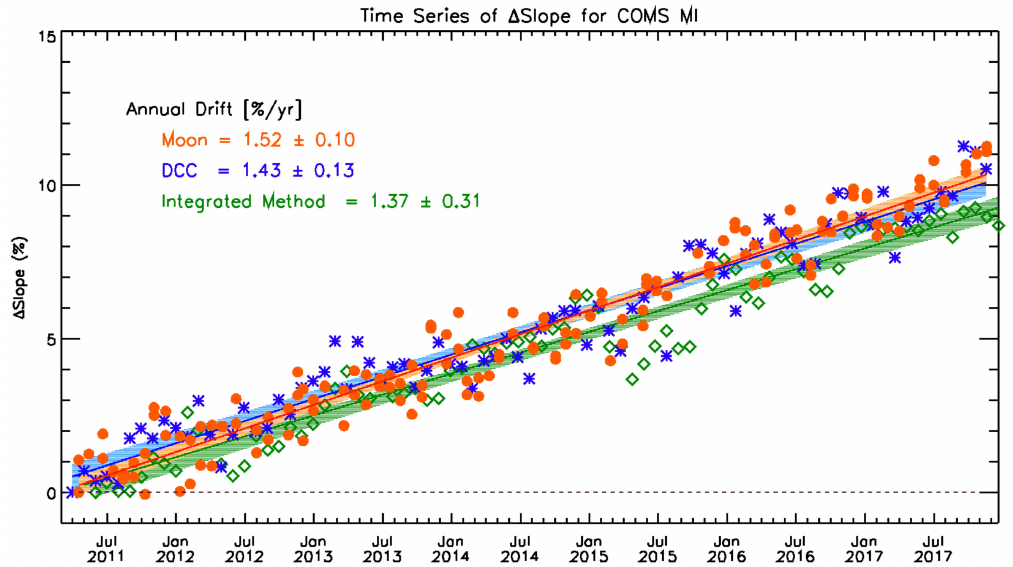
Figure 4. Comparison of visible channel degradation of COMS imager among several calibration methods: Moon (orange dot), DCC (using RTM) (blue asterisk) and integrated method (green diamond) from April 2011 to December 2017. The shades represent the 95% confidence interval of the linear regression for moon (orange shade) and DCC (light blue